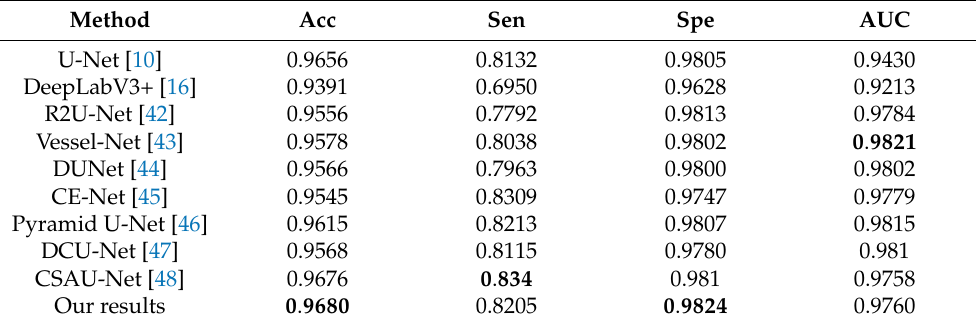
Figure 7. An example of results in Table 2. From left to right: ground truth, results with original softmax, and results with proposed regularization. Table 3. Performance of different models on DRIVE. The best values are